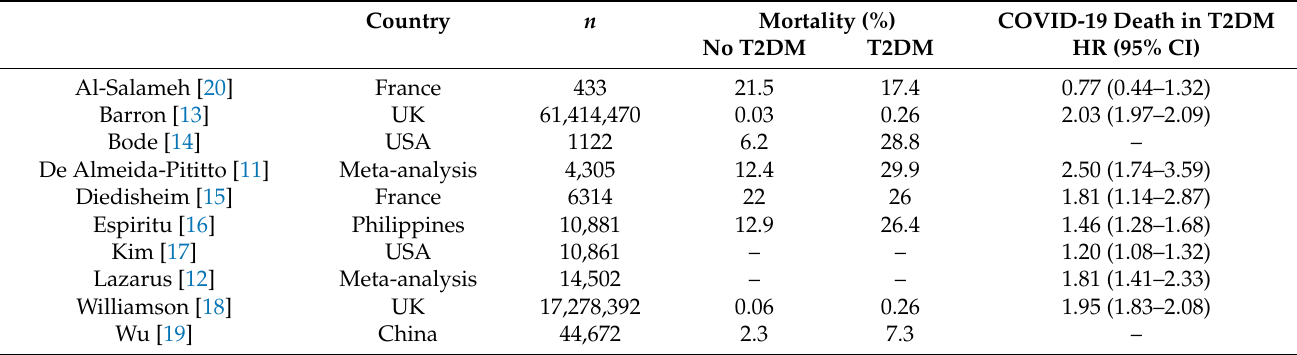
Table 1. COVID-19 Death in T2DM: Summary of the main results. Country n Mortality (%) COVID-19 Death in T2DM No